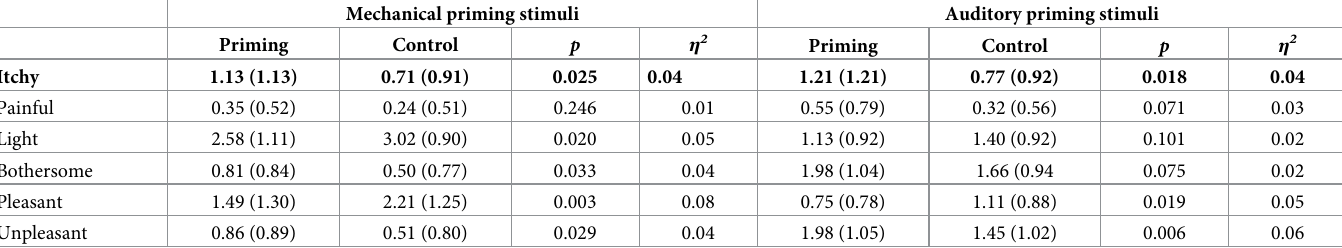
Table 1. M (SD ) for the ratings of the mechanical and auditory stimuli for the priming group ( n = 63) and the control group ( n = 64). P -values with bootstrapped residuals are reported to indicate significant group differences due to skewd distributions. Parametric effect sizes ( η 2 ) are reported. ‘Itchy’ as the descriptor of main interest is printed